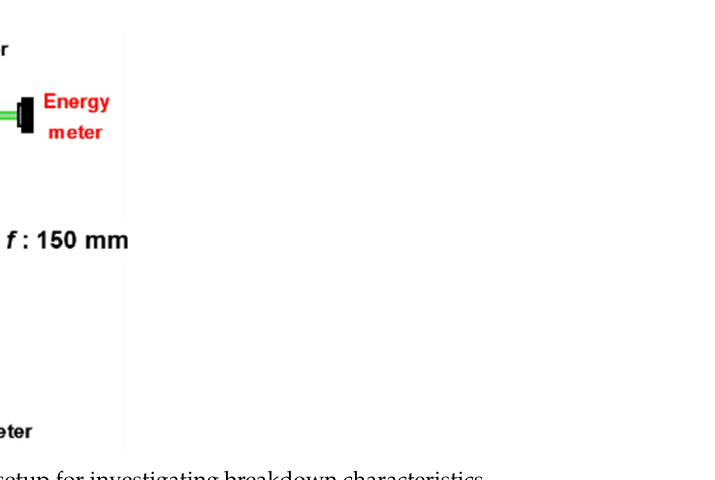
Figure 2. Experimental setup for investigating breakdown characteristics.